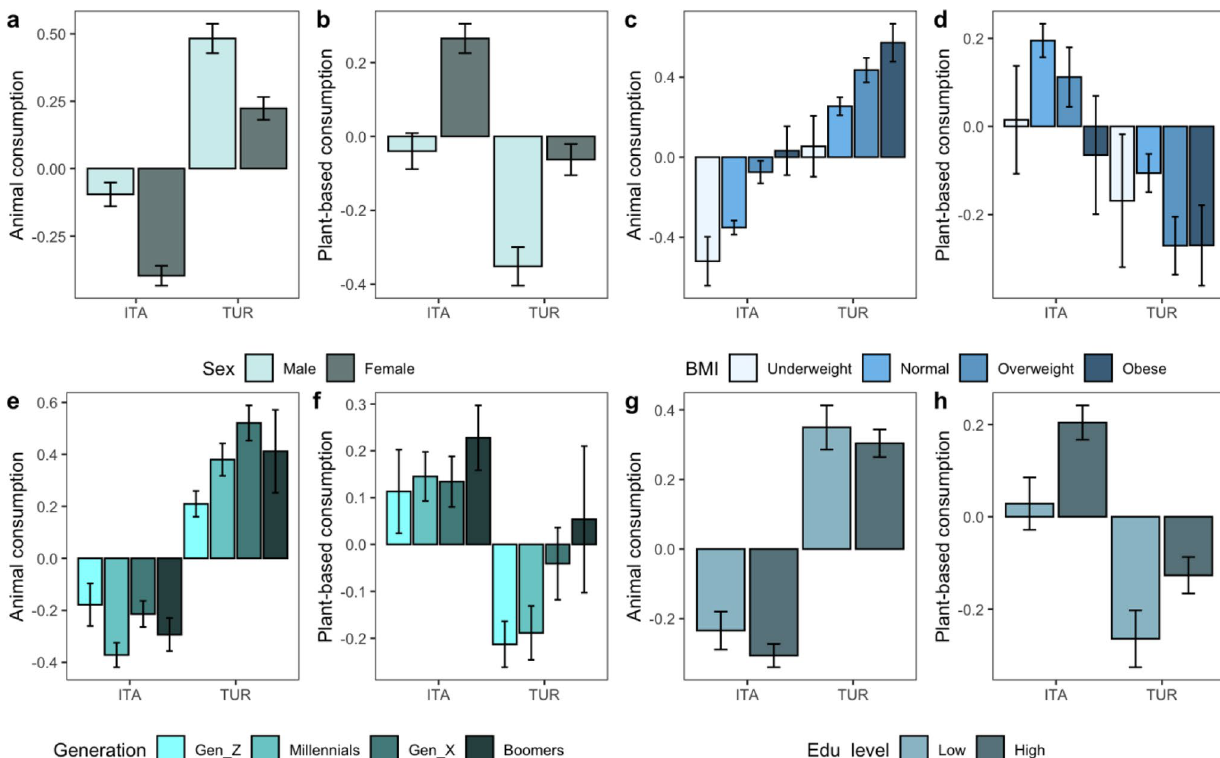
Figure 2. Summary of the results taking into account demographic characteristics: sex ( a,b ), BMI ( c,d ), generation ( e,f ), and education level ( g,h ) modulations on the frequency of consumption of animal- and plant- based foods among Italian (ITA) and Turkish (TUR)